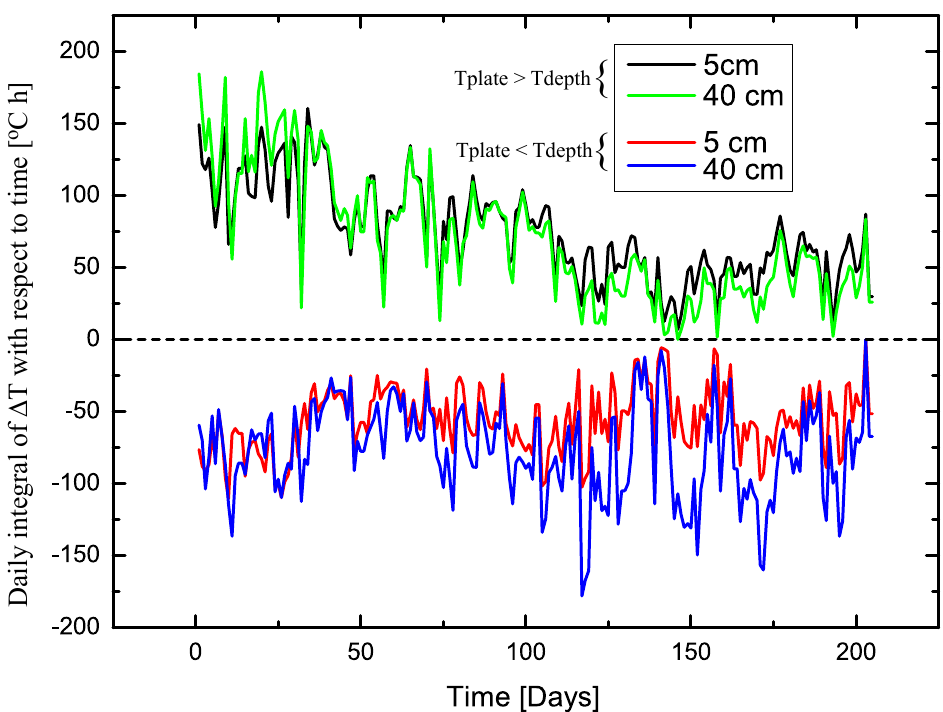
Figure 8. Daily integral of temperature difference ( T plate − T depth ) with respect to time, for depths of 5 cm and 40 cm, from 23 June 2015 to 13 January 2016 (period of 205 days).